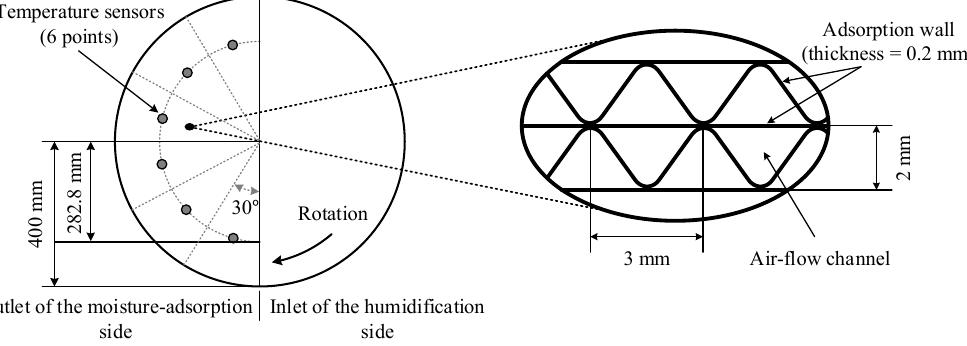
Figure 2. Dimensions of desiccant wheel and channel, and measuring points of temperature at the outlet on the moisture-adsorption side of desiccant wheel.